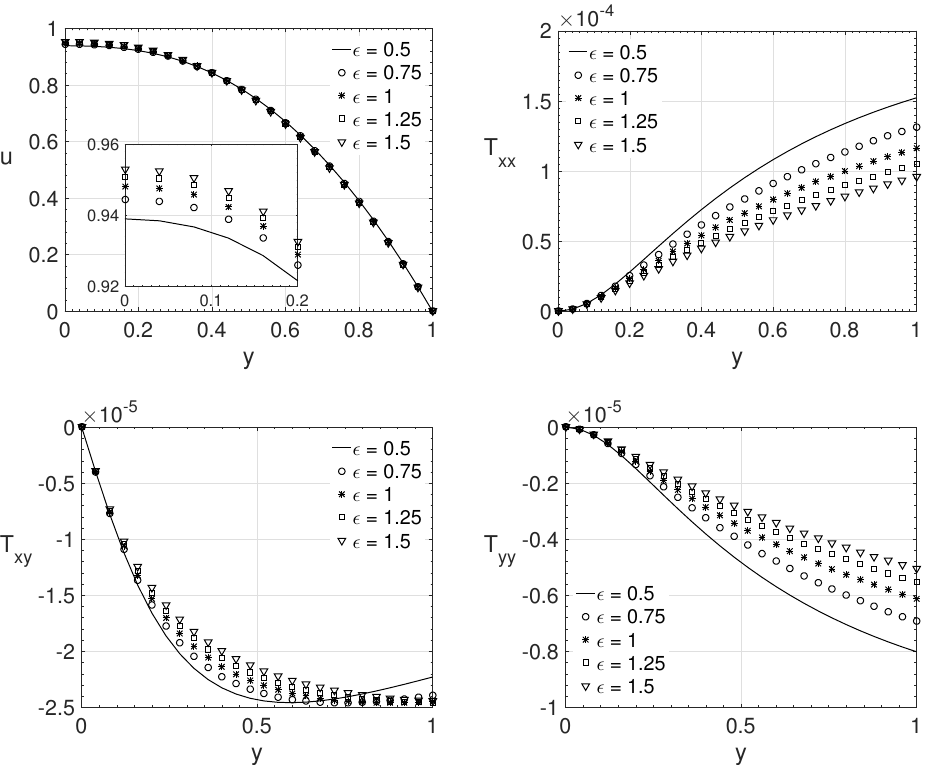
Figure 4. (cid:101) influence on the wall-normal variation y of the streamwise velocity component u and the extra-stress tensor components T xx , T xy and T yy . Dimensionless parameters: Re = 5000, β = 0.25, ξ = 0.1 and Wi =